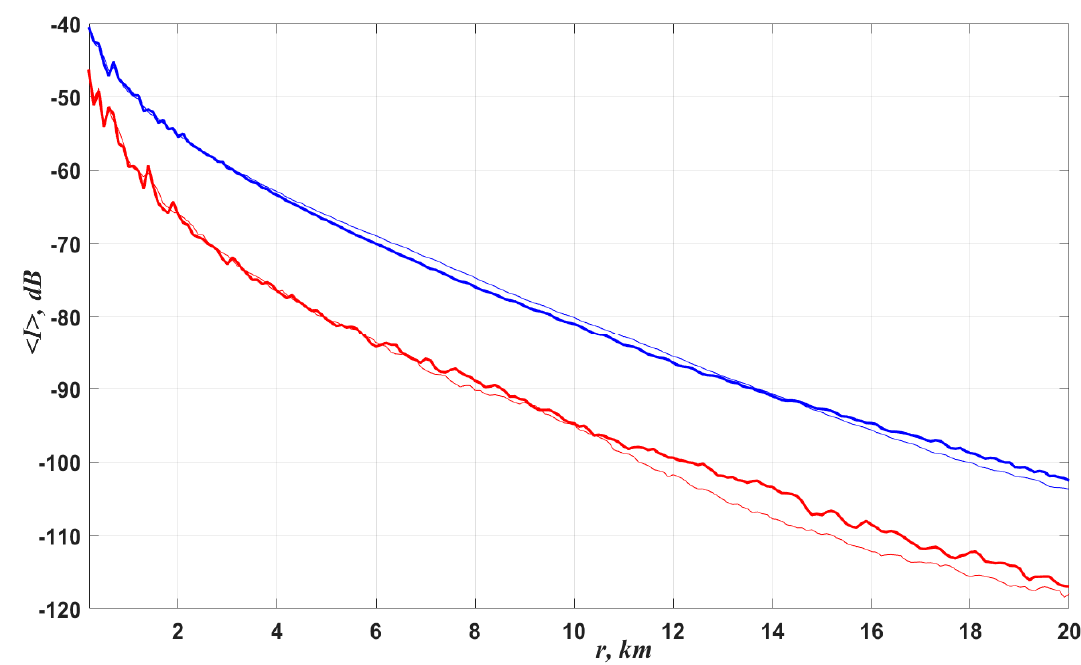
Figure 8. Transmission loss for a waveguide with Gaussian fluctuations ε (thin curves) and with fluctuations ε 2 ( r ) having log-normal probability distribution (bold curves); L z = 20 m, L r = 4 km. Parameters of the bottom: c 1 = 1530 m / s, ( ρ 1 / ρ 0 ) = 1.5, β 1 = 0.01. H - z 0 = 42 m. Blue curves: H - z = 42 m, red curves: H - z = 26 m.